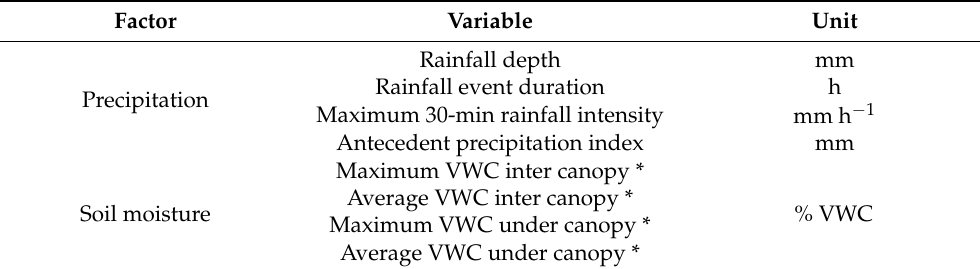
Table 1. Variables evaluated in the study of soil moisture dynamics of three micro-catchments in a semi-dry forest in Chihuahua,